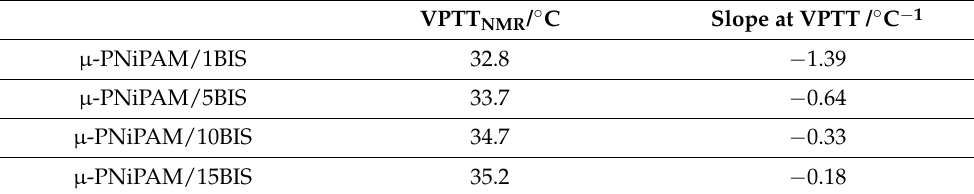
Figure 2. (i) Integrated normalized polymer signals in the range of δ = 1–3 ppm as acquired in temperature-dependent 1 H-NMR spectra (circles; left and bottom axis, integrals are normalized on the lowest temperature) and (ii) extracted VPTTs (squares; right and top axis) for neat microgels containing different crosslinker content. Color code as indicated in the legend. Dashed line is guide to the eye. Solid lines are fits according to Equation (4). Table 1. Fit results of 1 H NMR intensities for neat µ-PNiPAM/x-BIS microgels in D 2 O.